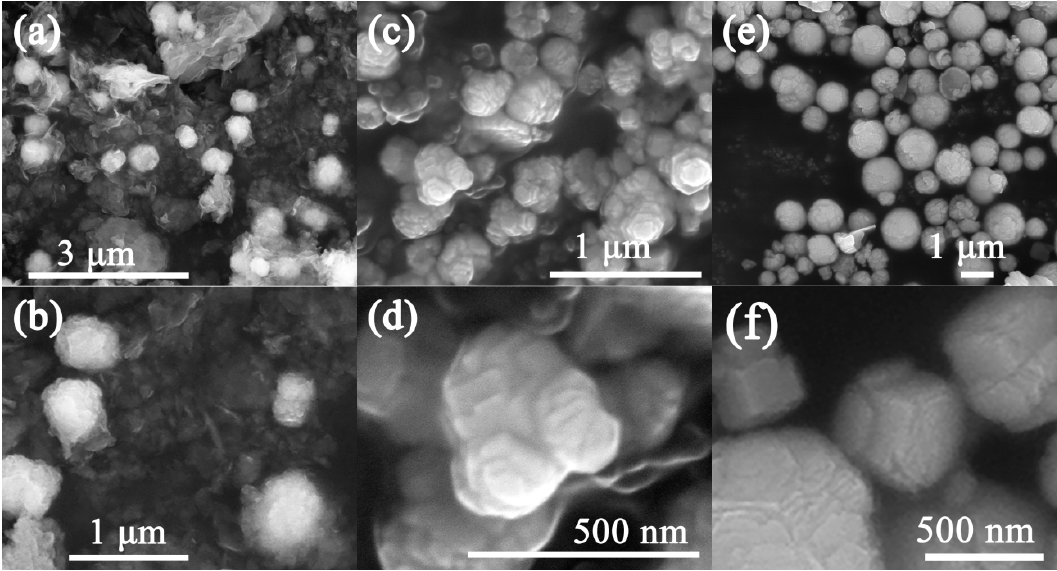
Figure 4. ZnO obtained with different reaction times: 5 min ( a , b ), 10 min ( c , d ), or 20 min ( e , f ).